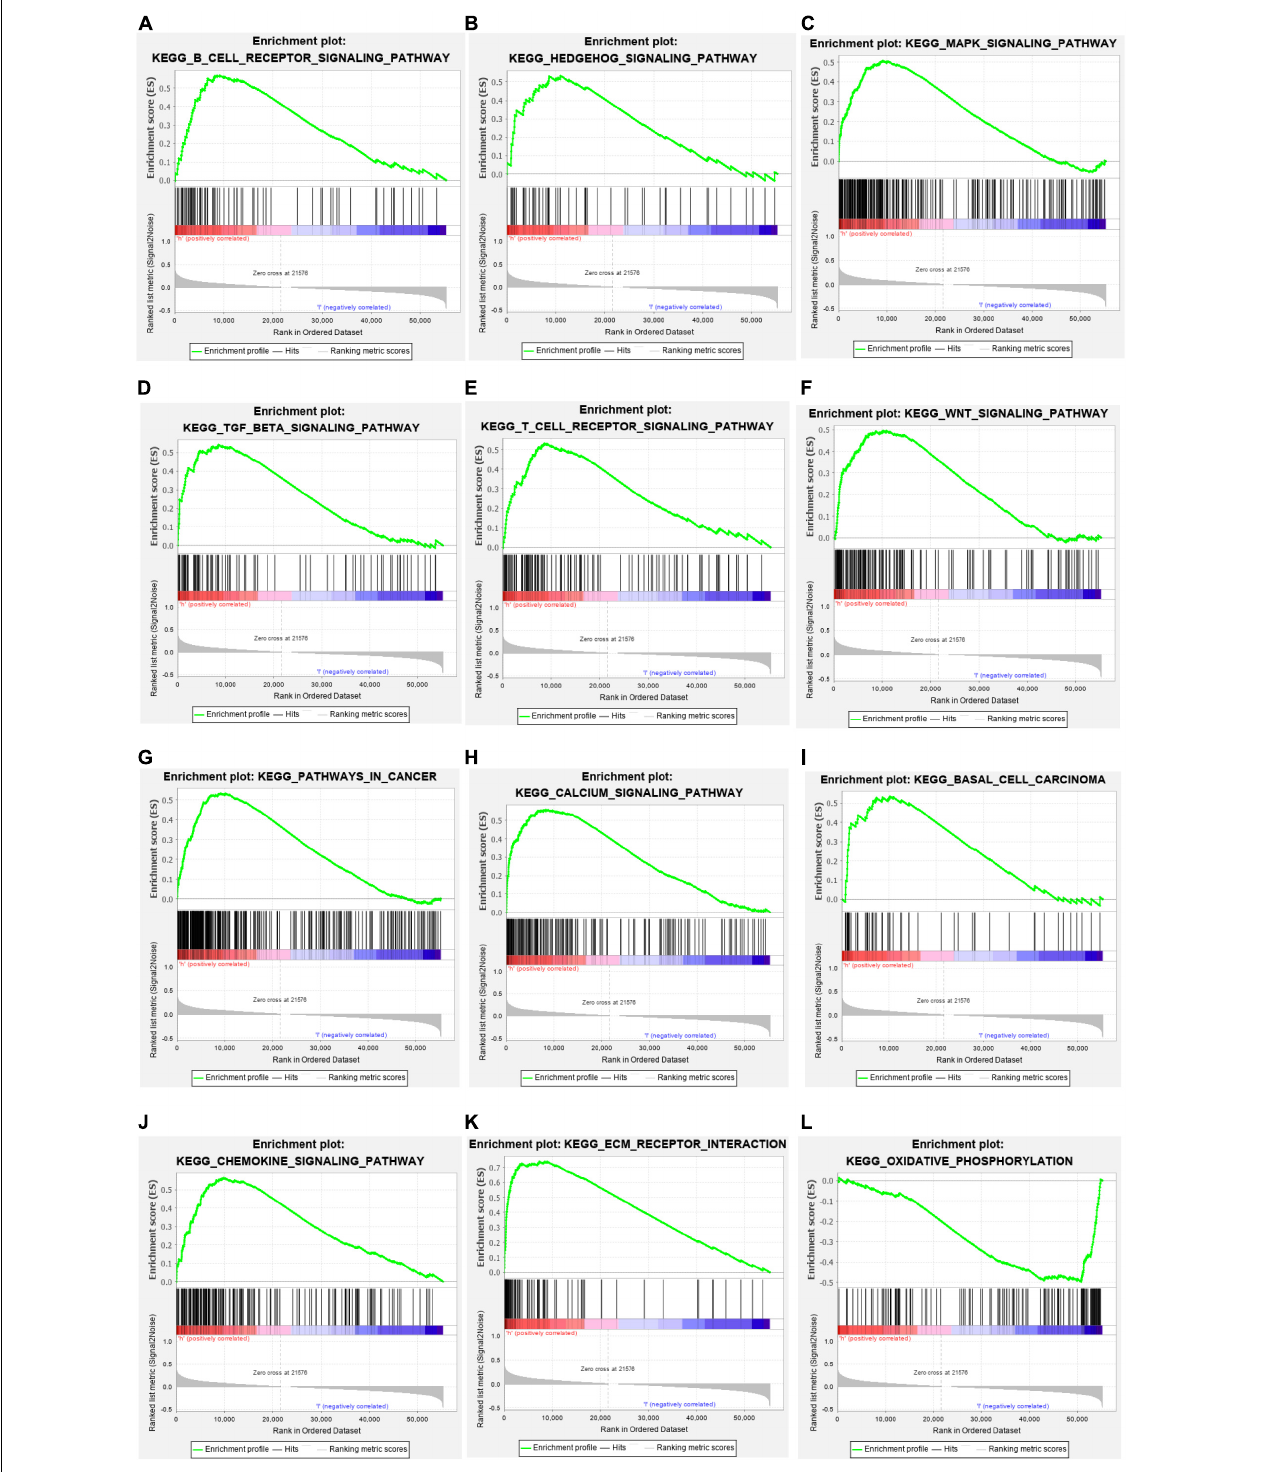
FIGURE 7 | Enrichment analysis. (A–L) KEGG pathway analysis indicates that these glycolysis related lncRNAs were involved in the B cell and T cell receptor signaling pathway, Hedgehog signaling pathway, MAPK signaling pathway, TGF- β signaling pathway, chemokine signaling pathway, EMC receptor interaction, and oxidative phosphorylation